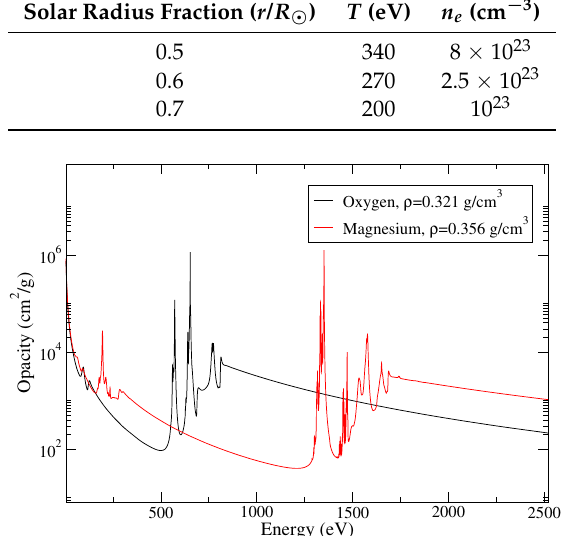
Table 3. Temperature and free-electron density at different depths of the Standard Solar Model computed with the MESA code [51] for the Asplund et al. composition [8]. Solar Radius Fraction ( r / R (cid:12) )